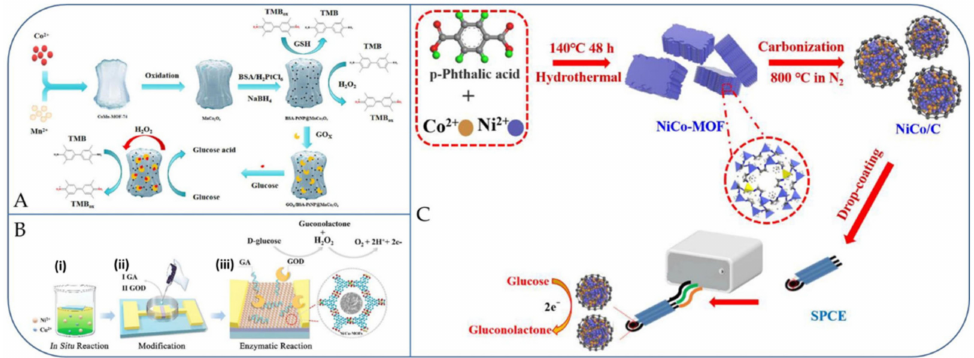
Figure 5. ( A ) Schematic fabrication and biosensing mechanism of BSA-PtNP@MnCo 2 O 4 -based highly-efficient enzyme cascade glucose biosensing platform; ( B ) schematic fabrication of GOD- GA-Ni/Cu-MOFs-FET electrode for glucose biosensing. (Step “i”) The FET was suspended on the surface of reaction solution with mixed bimetallic ions. (Step “ii”) The Ni/Cu-MOFs was developed by dipping GA and GOD successively for enzymatic reaction. (Step “iii”) Ions produced from the enzymatic reaction of glucose collected on the surface of bimetallic MOFs surface, and the oxidized products of glucose; ( C ) the fabrication steps of NiCo/C electrode for nonenzymatic glucose biosensing. Reproduced with permission from Refs.